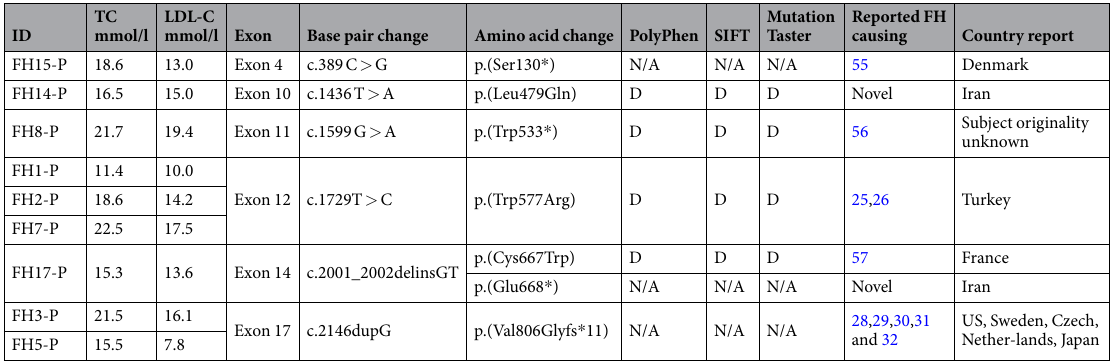
Table 3. Identified LDLR mutation in an Iranian patient with FH. D: Deleterious, P: Possibly damaging, B: Benign, N/A: not applicable.